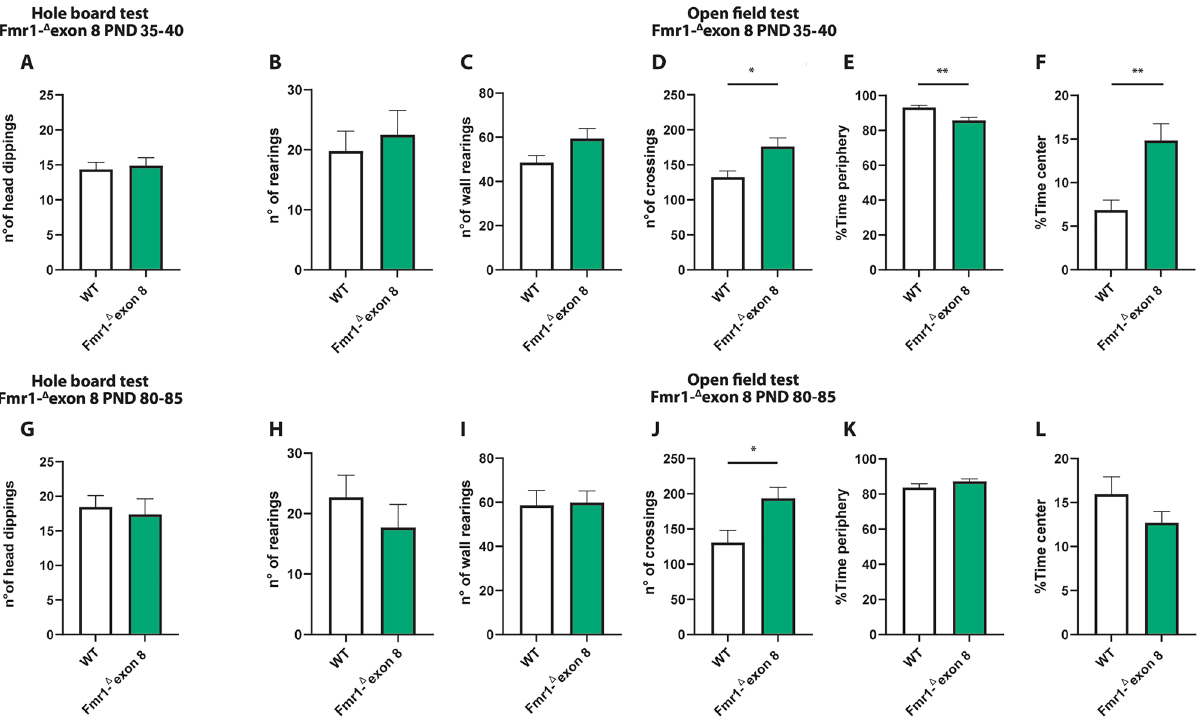
Figure 2. Behavioral studies: Stereotyped behavior and locomotor activity in Fmr1- Δ exon 8 rats. Both juvenile ( A ) and adult ( G ) Fmr1- Δ exon 8 rats did not display repetitive behaviors in the hole board test as the number of head dippings did not differ between wild-type (WT) and Fmr1- Δ exon 8 rats (PND 35-40: WT = 11; Fmr1- Δ exon 8 = 14; PND 80-85: WT = 18; Fmr1- Δ exon 8 = 15). Moreover, juvenile and adult Fmr1- Δ exon 8 rats did not display repetitive behaviors in the open field test as their number of rearings ( B and H ) and wall rearings ( C and I ) was similar to WT animals. Conversely, Fmr1- Δ exon 8 rats displayed hyperactivity in the open field test as expressed in the increased number of crossings when compared to WT controls ( D and J ). Moreover, juvenile Fmr1- Δ exon 8 rats spent less time in the periphery of the open field ( E ) and longer time in the center of the arena ( F ) as compared to WT rats. These differences were not observed at adulthood ( K and L, respectively) (PND 35-40: WT = 8; Fmr1- Δ exon 8 = 8; PND 80-85: WT = 10; Fmr1- Δ exon 8 = 10). Data represents means ± SEM. * p < 0.05, ** p < 0.01 versus WT group (Student’s